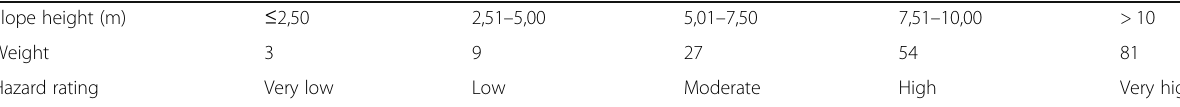
Table 7 The modified slope height classification Slope height (m) ≤ 2,50